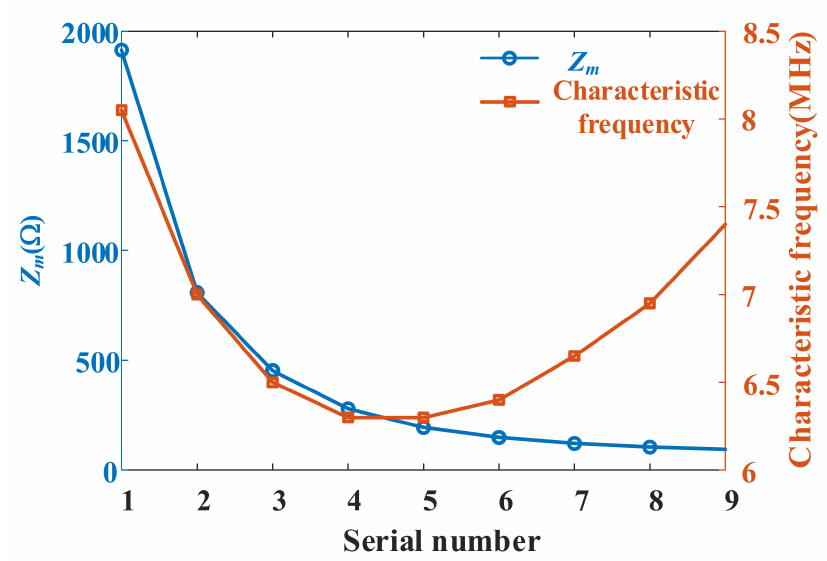
Figure 12. The relationship between the degree of aging and the characteristic frequency with its impedance